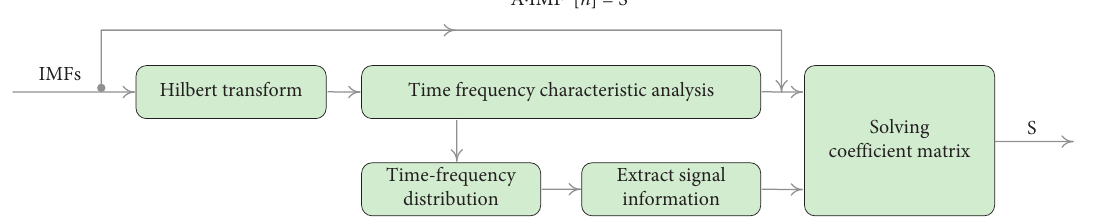
Figure 3: Procedure of target signal